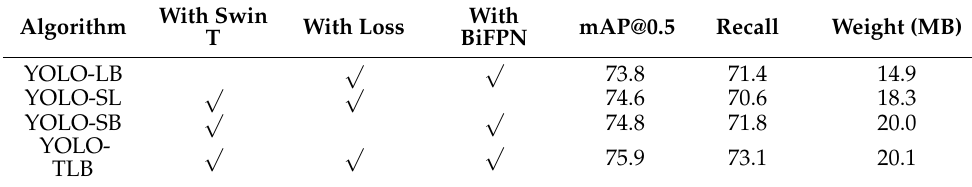
Table 3. Ablation experiment.